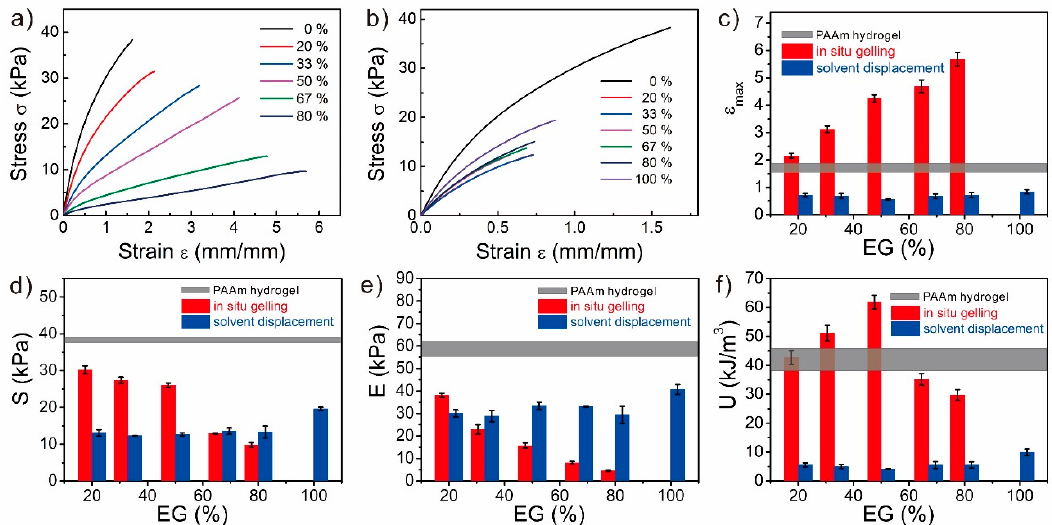
Figure 6. Mechanical properties of the PAAm gels with various EG contents from both synthesis strategies. ( a , b ) Stress-strain curves of the PAAm gels with various EG contents from ( a ) in-situ gelling and ( b ) solvent displacement. ( c ) Tensile strain, ( d ) tensile stress, ( e ) elastic modulus, and ( f ) toughness of the PAAm gels as the functions of the EG content. The horizontal grey lines ( c – f ) indicate the data from PAAm hydrogels, and the width of the line represents the error range.